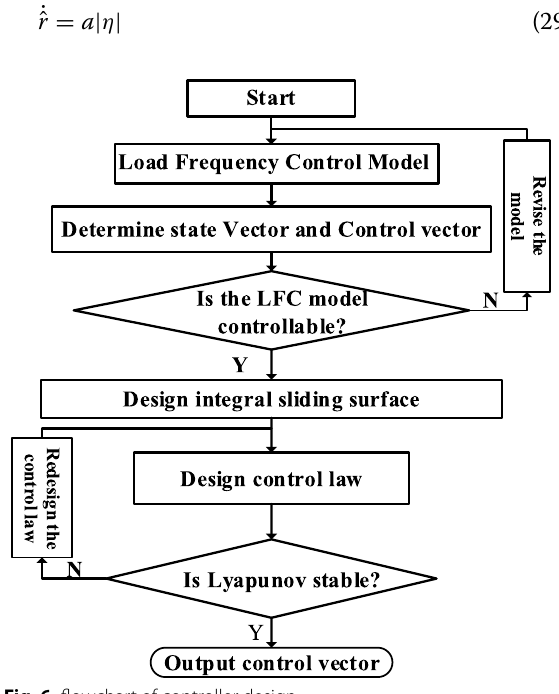
Fig. 6 flowchart of controller